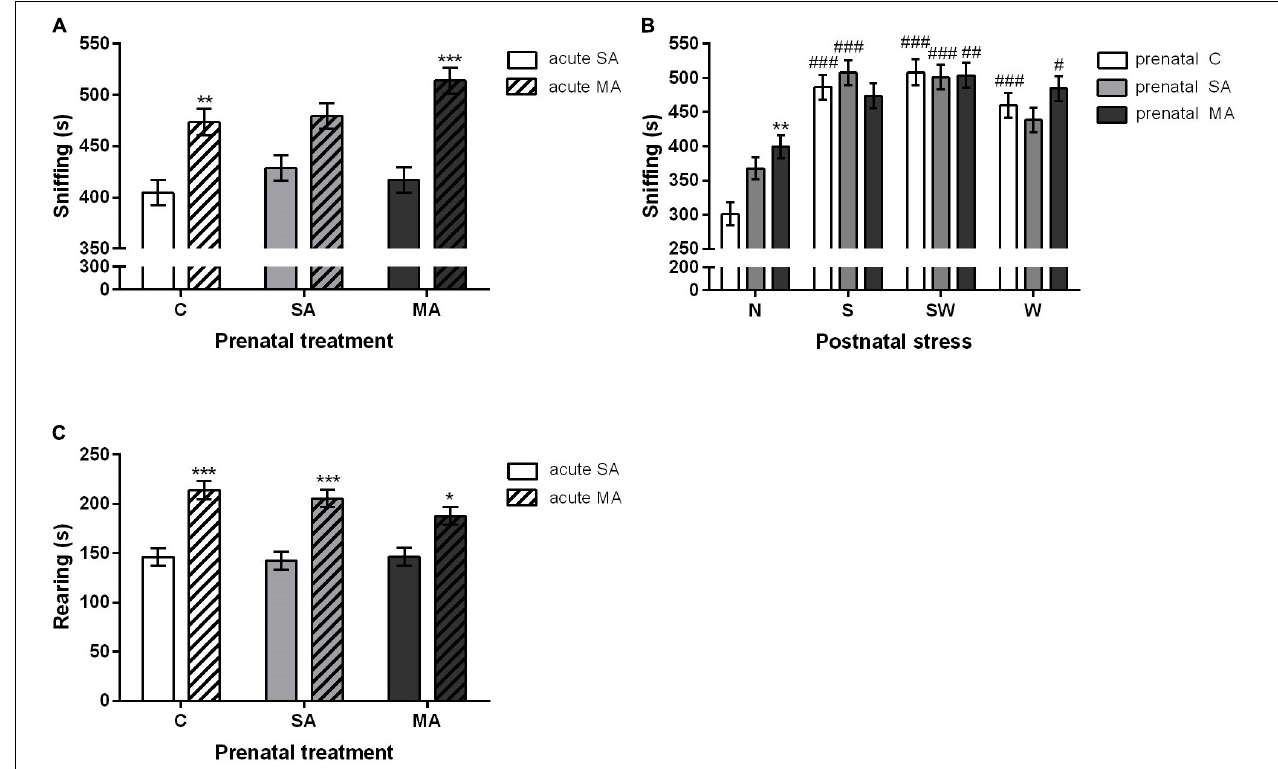
FIGURE 4 | The effect of perinatal treatment and acute MA administration on sniffing and rearing behavior in the open field test. (A) Sniffing time, (B) sniffing time, and (C) rearing time. Values are means ± SEM. C, control; SA, saline; MA, methamphetamine; N, non-stressed controls; S, maternal separation; W, maternal cold water swimming stress; SW, maternal separation plus maternal cold water swimming stress. Acute SA indicates a single direct saline injection prior to testing, and acute MA indicates a single direct methamphetamine injection prior to testing. * p < 0.05, ** p < 0.01, *** p < 0.001 significant differences in one group on the x -axis. # p < 0.05, ## p < 0.01, ### p < 0.001 significant differences between the group in the legend and its N